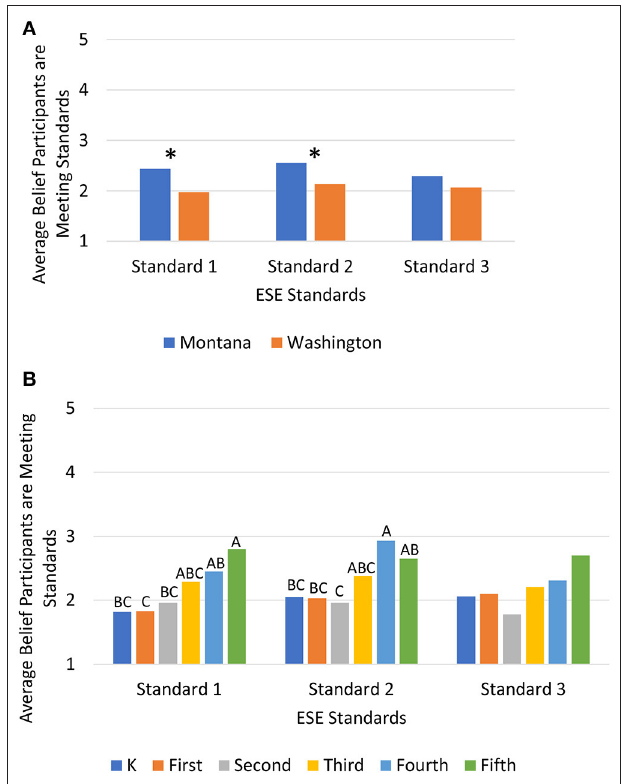
FIGURE 7 | The average level of belief that participants (A) from Washington ( n = 75) and Montana ( n = 78) and (B) that teach each grade level are meeting the three ESE Standards (K n = 17, 1st n = 29, 2nd n = 27, 3rd n = 24, 4th n = 29, 5th n = 20). Asterisks represent significant differences, and grade levels not connected by the same letter are significantly different.